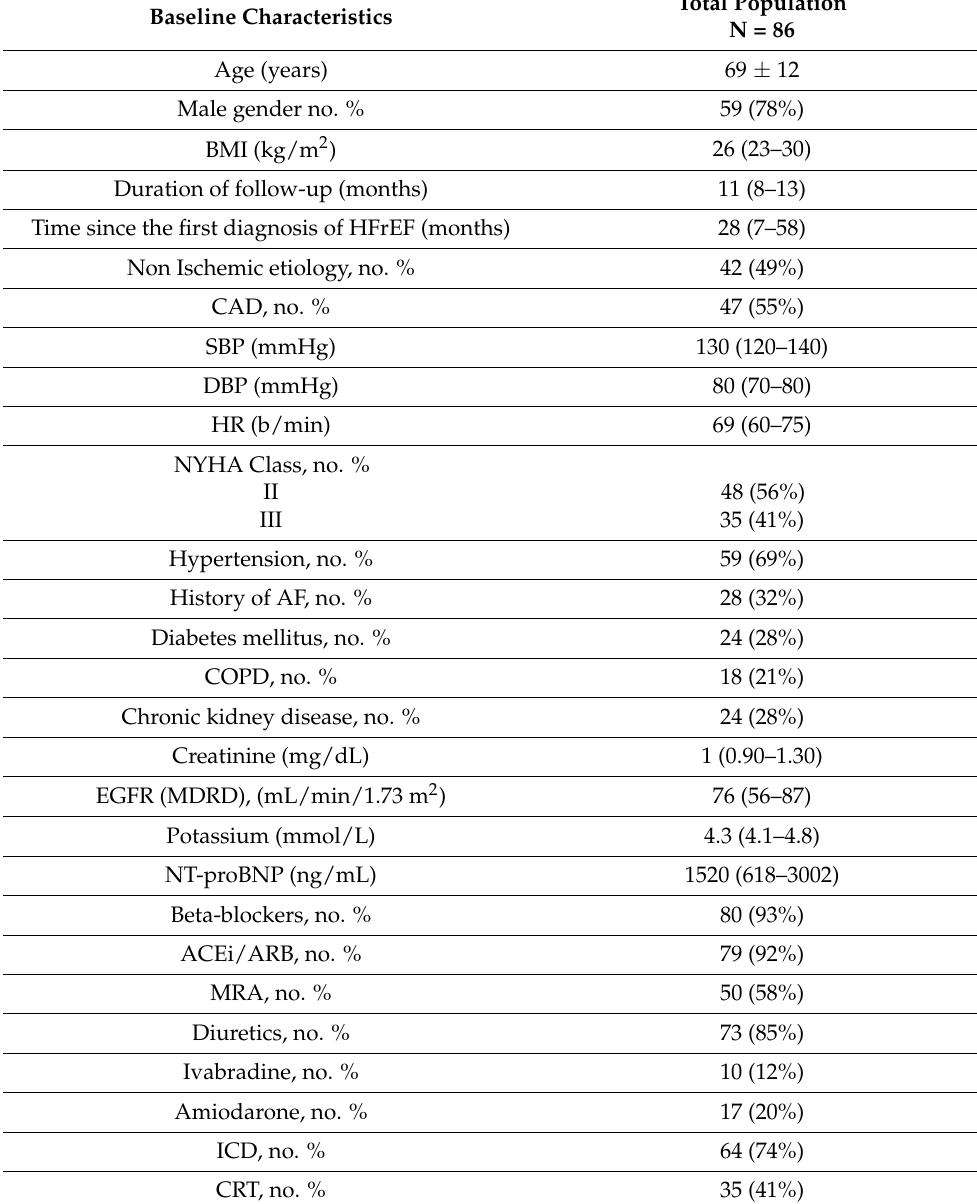
Table 1. Characteristics of the study population at baseline. Continuous variables are presented as average and standard deviation or median and 25–75th percentile as appropriate. Categorical variables are presented as absolutes and